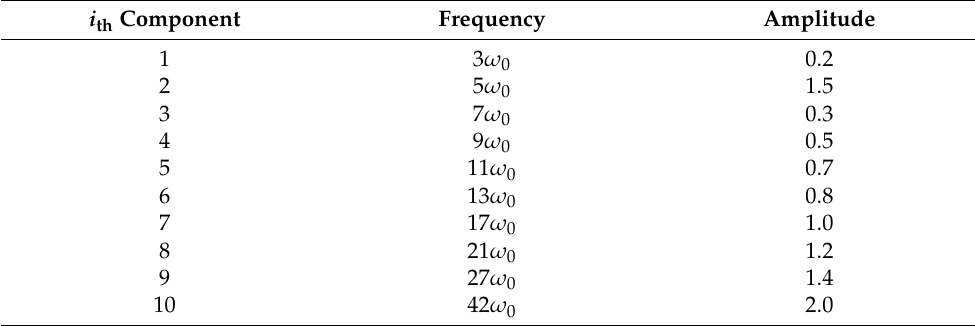
Table 2. Sinusoidal components of the input torque signal τ 1 .